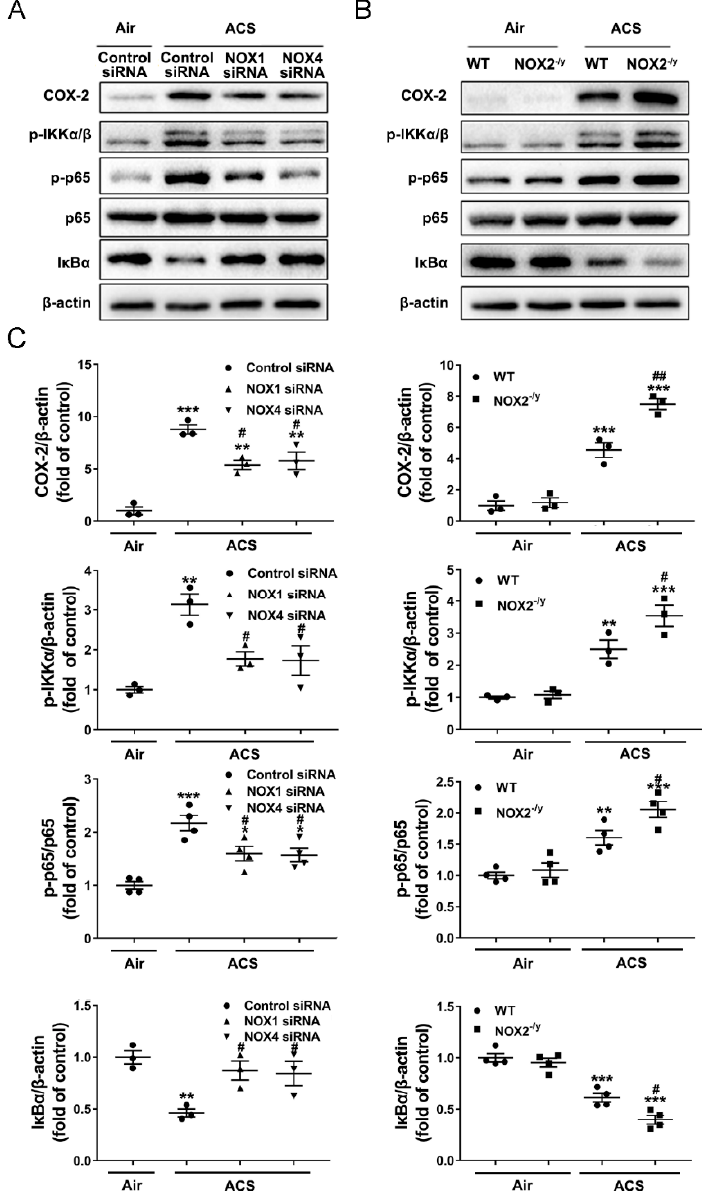
Figure 8. Knockdown of NOX1 or NOX4 attenuated ACS induced activation of the NF- κ B-COX-2 pathway in the mouse lung . Mice were exposed to CS or filtered air for 1 h and harvested at 6 h. Western blotting was used to examine COX-2, p-IKK α / β , p-p65, p65, and I κ B α protein expression in mouse lungs. ( A , B ) Representative Western blots of COX-2, p-IKK α / β , p-p65, p65, and I κ B α protein expression in ACSexposed mice silenced or knocked out of NOX1, NOX2, or NOX4. ( C ) Grouped data of COX-2, p-IKK α / β , p-p65, p65, and I κ B α protein expression in ACSexposed mice silenced or knocked out of NOX1, NOX2, or NOX4. The data indicate that ACSinduced activation of the NF- κ B-COX-2 pathway was significantly attenuated in NOX1- or NOX4-silenced mice, while it was increased in NOX2 − /y mice. All data are presented as Mean ± SEM, n = 3–5. * p < 0.05, ** p < 0.01, *** p < 0.001 vs. air-exposed control group. # p < 0.05, ## p < 0.01 vs. ACS-exposed group.